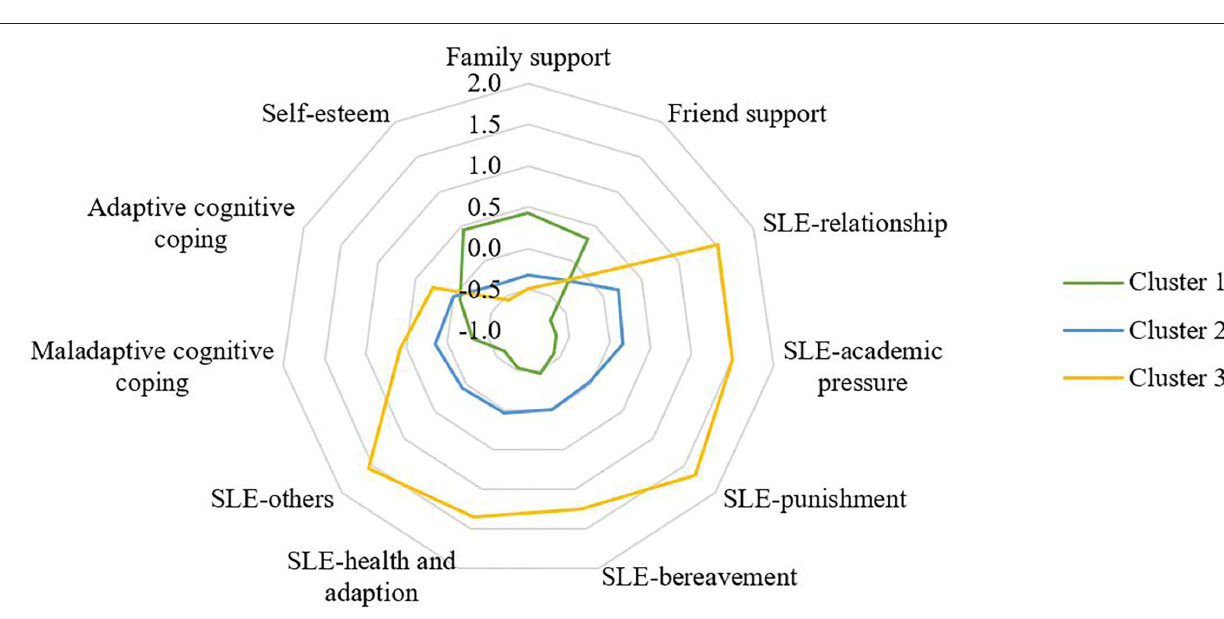
( Table 2 ). We also conducted multinominal logistic regression analysis to assess the associations between cluster membership and behavioral/mental health outcomes using the original response categories of dependent variables, which showed similar significant results ( Supplementary Table 3